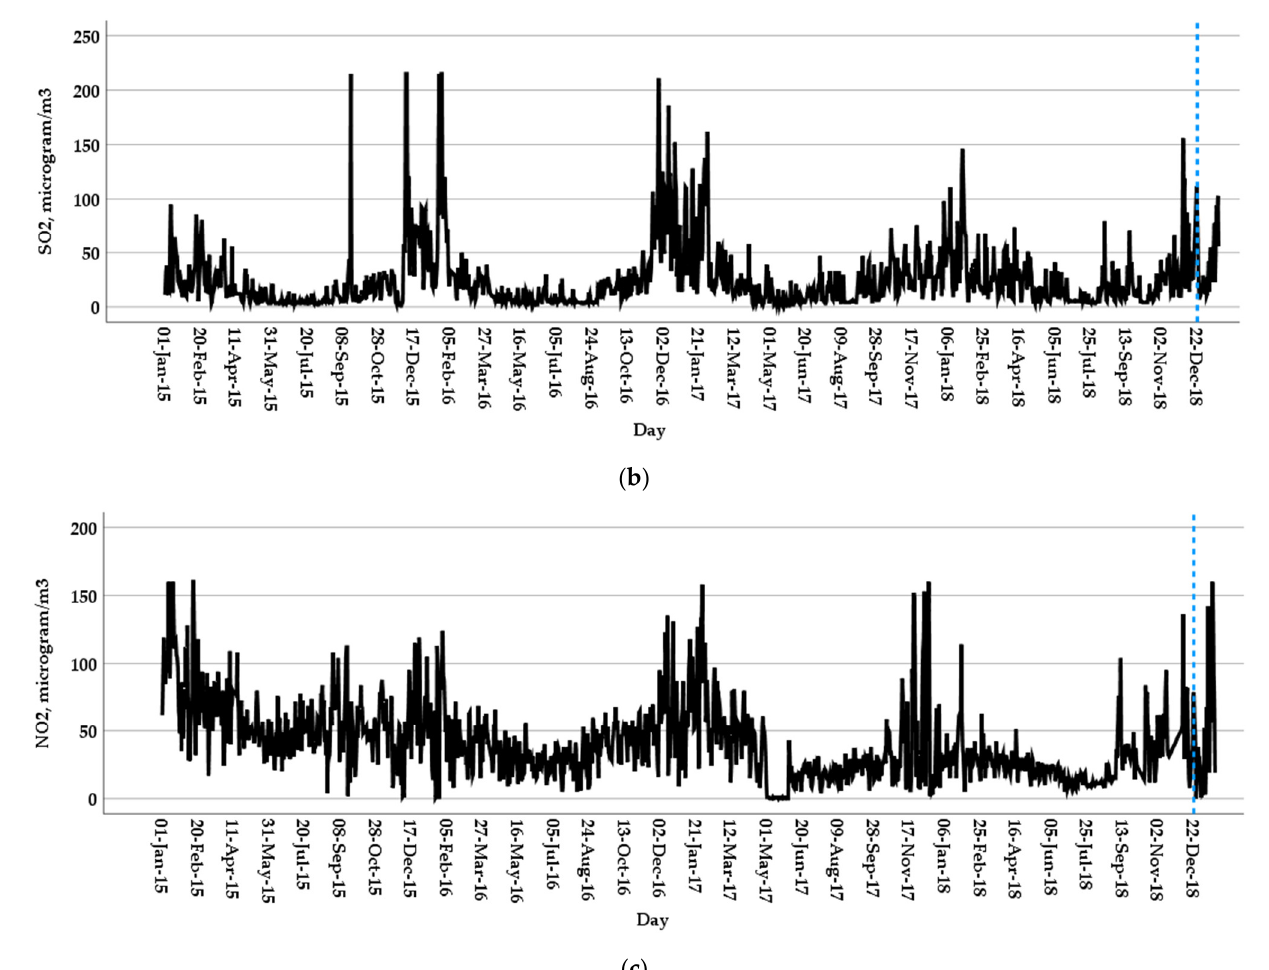
Figure 3. Sequence plots of the examined pollutant data: ( a ) PM 10 , ( b ) SO 2 , ( c ) NO 2 . The horizontal red line in ( a ) indicates the European and national standard for the upper daily PM 10 limit of 50 μg/m 3 . The blue vertical lines separate the training and test samples.